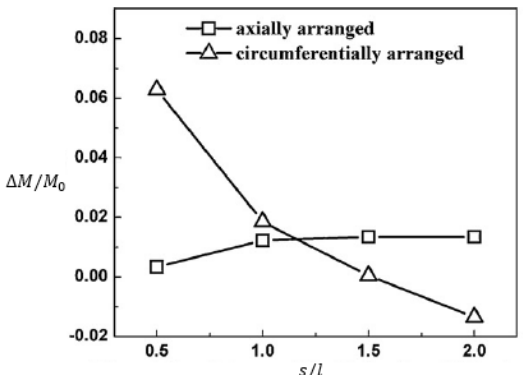
Figure 10. Graph of bending limit load against the interacting distance of double defects for shallow defects [60]. Note: ∆𝑀 is the difference between the bending limit load of a pipe with single defect, 𝑀 0 , and the bending limit load of pipe with double defects, 𝑀 . Thus, a value of 𝑀 0 /𝑀 approaching 1 suggests an increasing interacting behaviour.